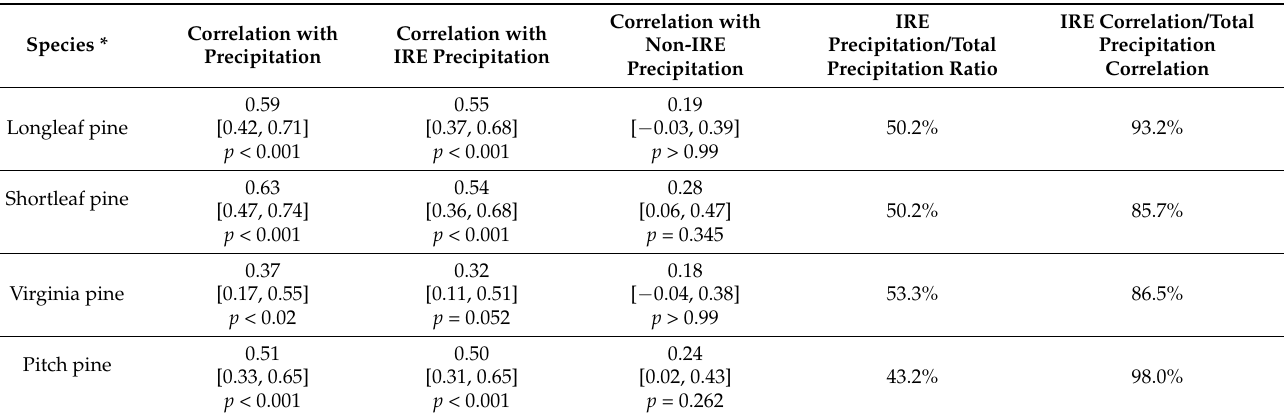
Table 2. Correlations with total precipitation, IRE precipitation, non-IRE precipitation for each species, and the proportion of total precipitation correlation coefficient explained by IRE precipitation. Ratio of IRE precipitation to total precipitation during the selected